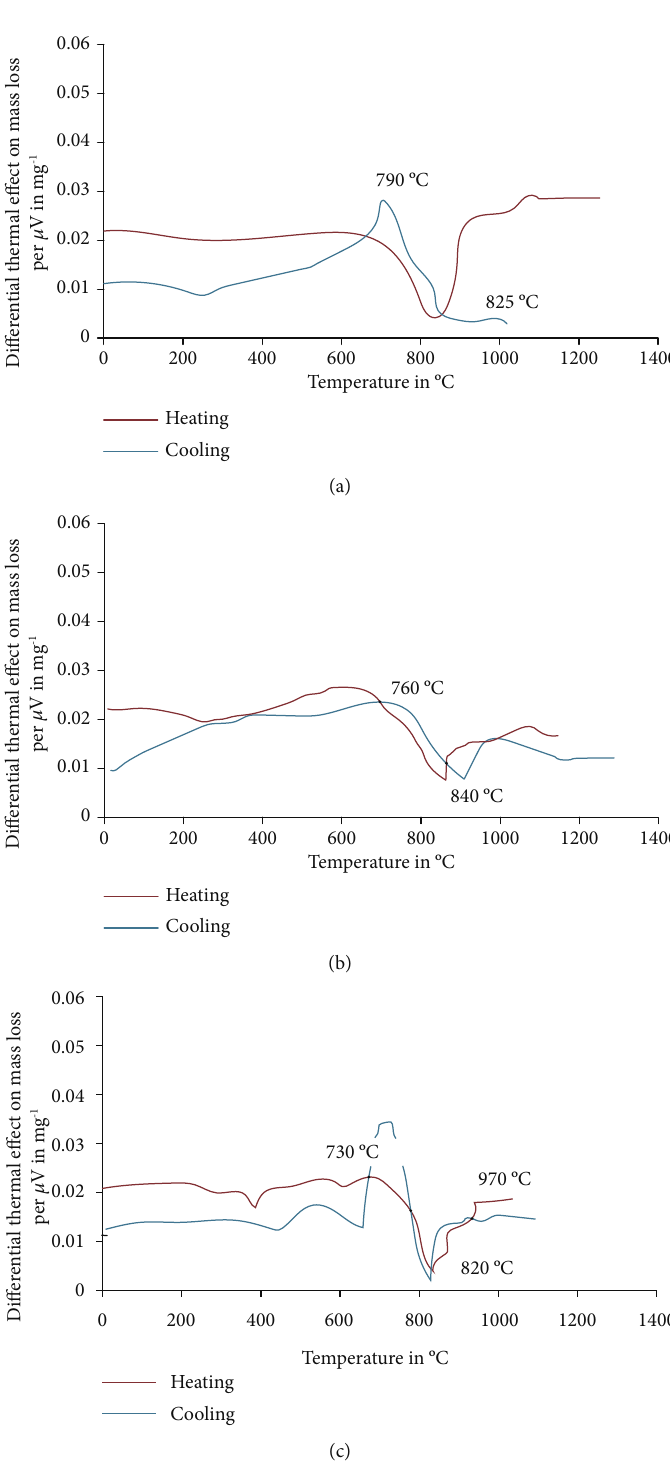
O /0 wt% SiC 2 3np